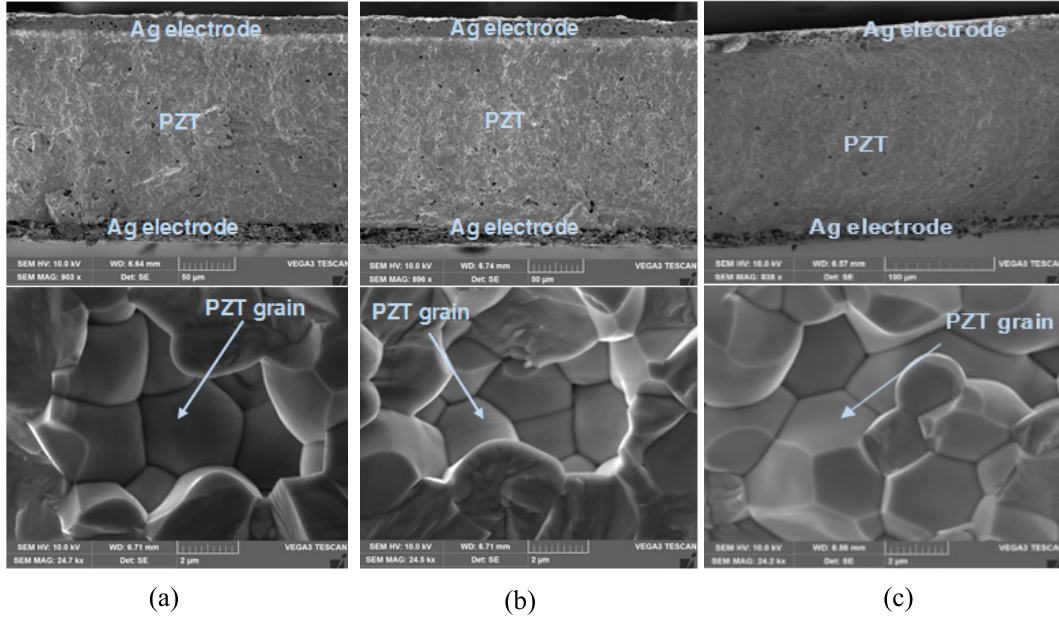
Figure 2. Scanning electron microscopy (SEM) image of the cross-section of PZT-PWAS: ( a ) at room temperature; ( b ) after exposure to 250 ° C temperature; ( c ) after exposure to 225 kGy nuclear radiation.